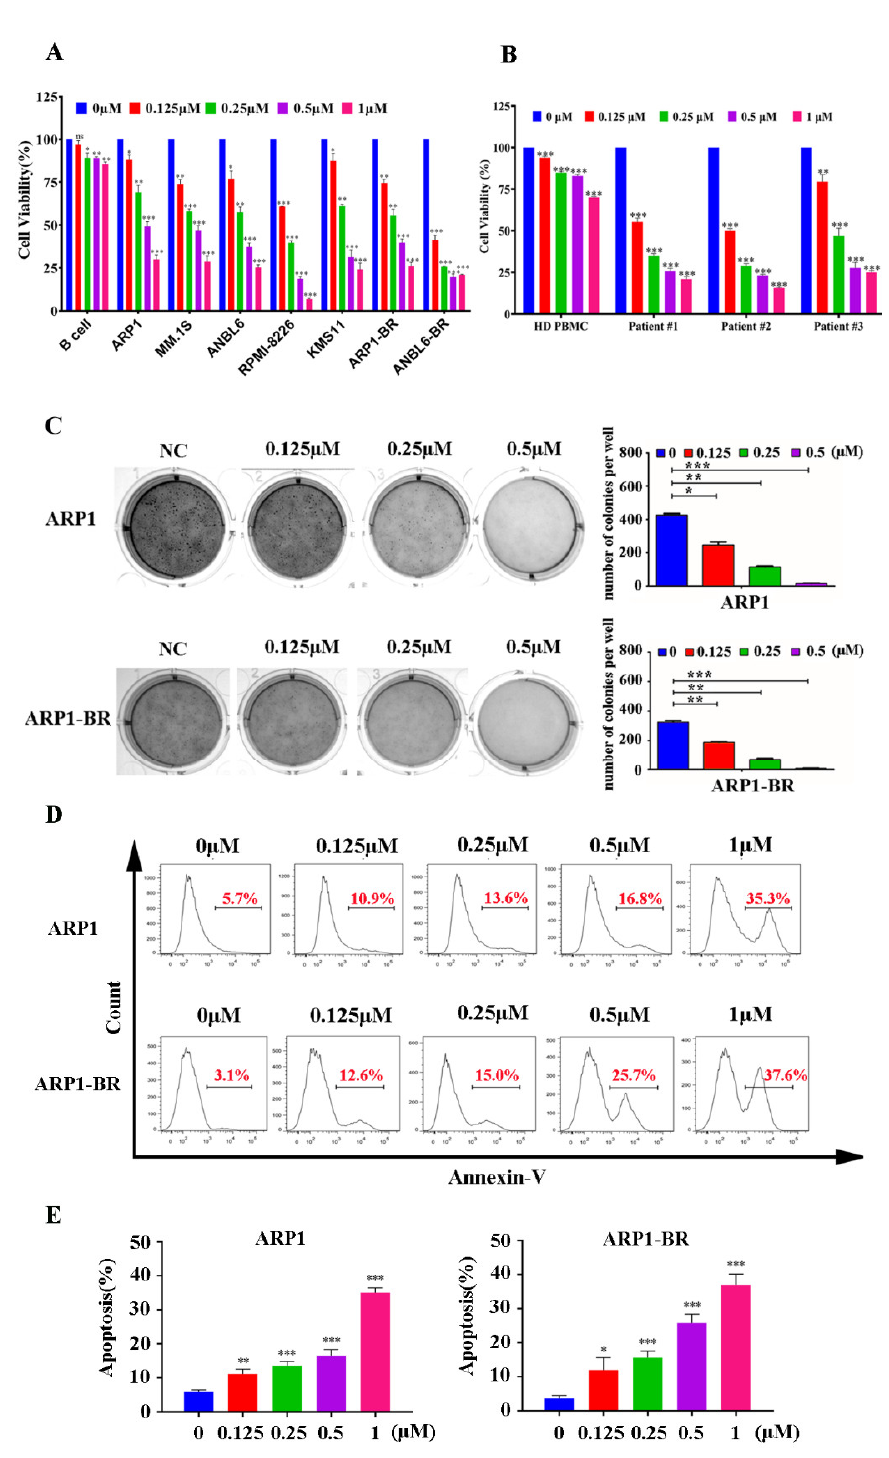
Figure 2. Periplocin inhibits proliferation and induces apoptosis in MM. ( A ) Effect of PP on cell viability of MM cell lines of different genetic backgrounds and B-cell lines with the mentioned concentrations for 24 h through CCK-8 assay. The survival rate of 0 µ M PP-treated cells was set to 100%. ( B ) Effect of PP on cell viability of primary CD138 + cells isolated from MM patients with indicated concentrations for 24 h through CCK-8 assay. ( C ) Effect of PP on colony-forming abilities of ARP1 and ARP1-BR cell lines treated with the mentioned concentrations of PP for 24 h by using clonogenic assay. The bar graphs represent the number of colonies. ( D ) The changes in apoptosis rate of ARP1 and ARP1-BR cells after treatment with PP with the mentioned concentrations for 24 h, were achieved through flow cytometry using Annexin V stain. ( E ) The bar graph representation of PP-induced apoptosis of ARP1 and ARP1-BR cell lines. The bar graphs demonstrated a mean ±